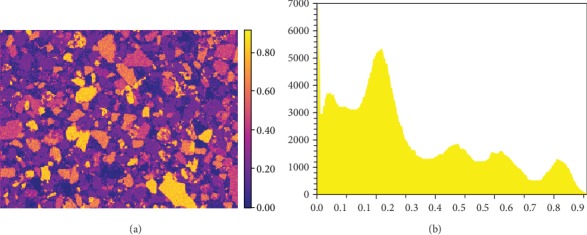
Si-Kαf-ratio map (a) and its histogram (b).